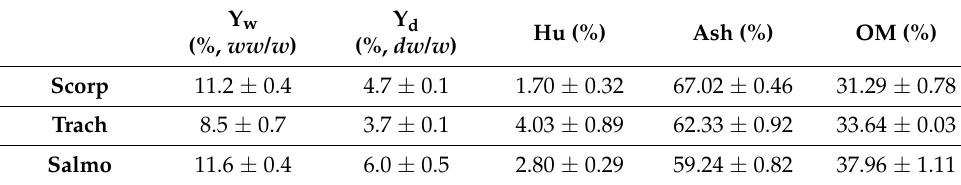
Table 1. Yields of bones recovered from the initial substrate.